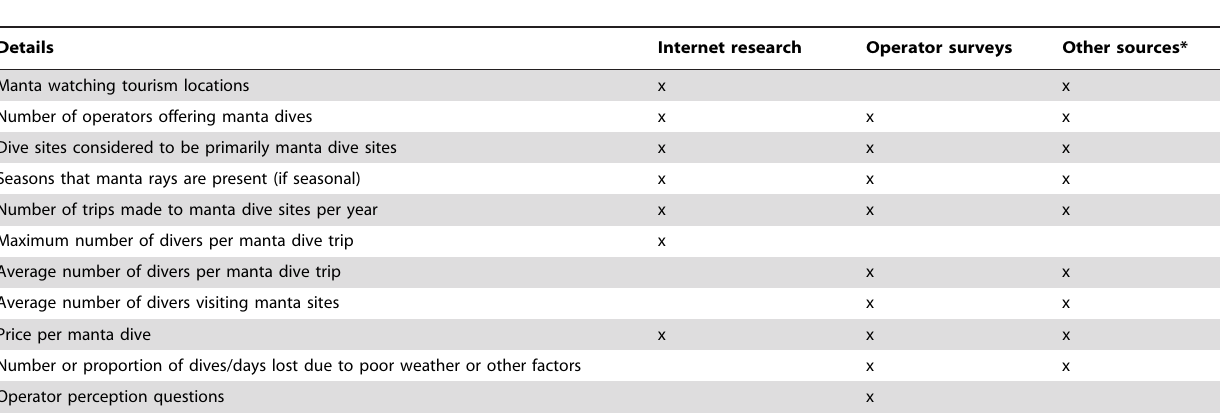
Table 1. Data Collection: Details collected and